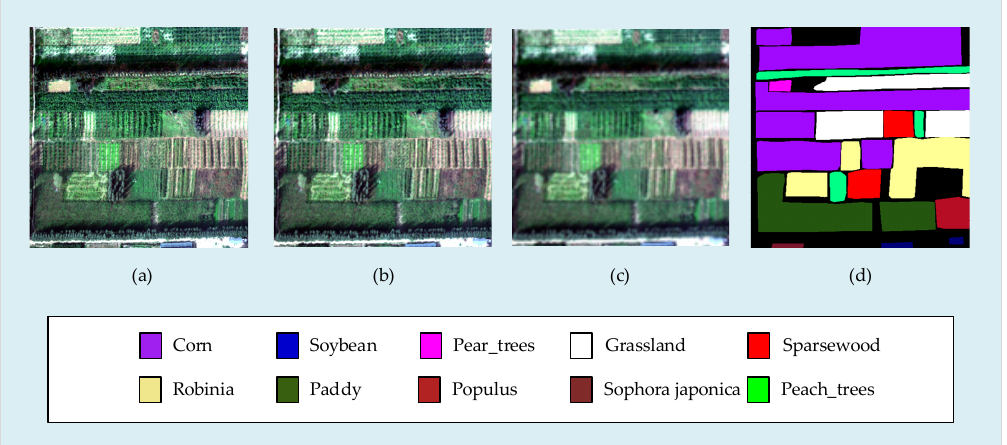
Figure 11. ( a ) The pseudo-colour image of Spatial_resolution_1 (0.5 m); ( b ) The pseudo-colour image of Spatial_resolution_2 (1 m); ( c ) The pseudo-colour image of Spatial_resolution_3 (2 m); ( d ) ground truth classification map. The numbers of samples and training samples used in the Xiong’an dataset with